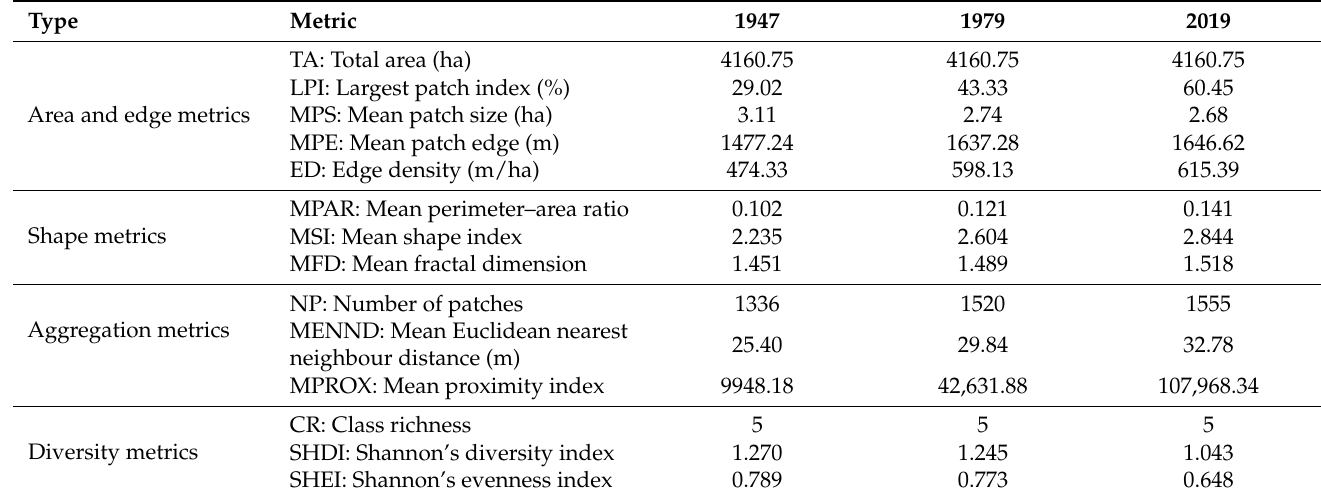
Table A1. Spatial metrics at the landscape level, for 1947, 1979, and 2019.